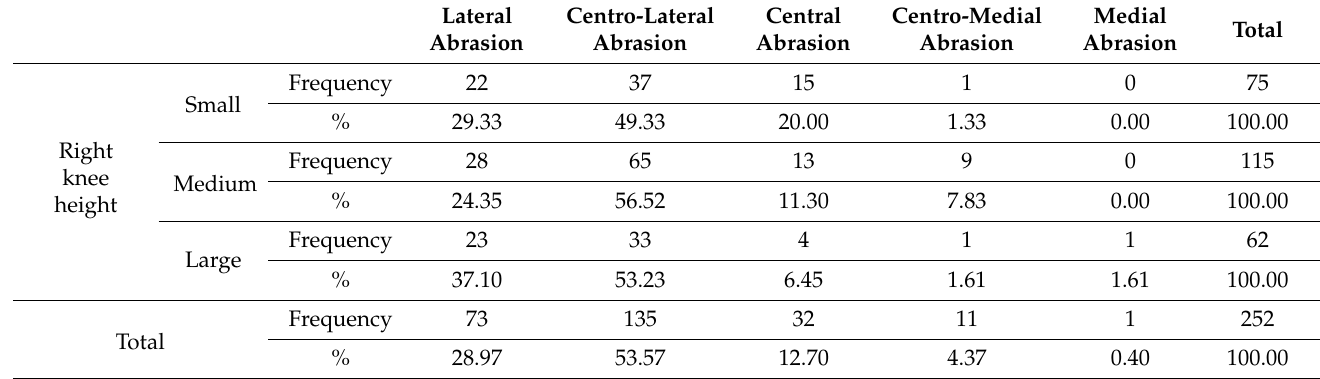
Table 14. Relationship between the right knee height and right shoe abrasion pattern (X 2 = 16.81, df = 8, p =